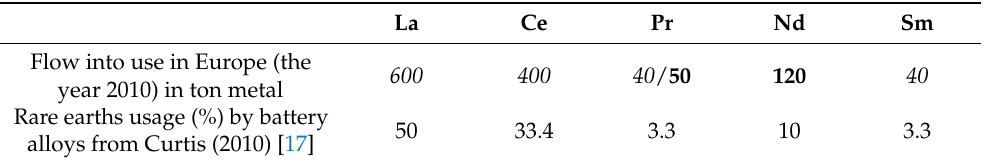
Table 2. Flow into use and content data for REEs with NiMH batteries in Europe for the year 2010 reported by Guyonnet et al. [8] (in bold script numbers) and Curtis [17] (in the normal script), respectively. The other flow in use-values are in italic script and were derived here (see text). La Ce